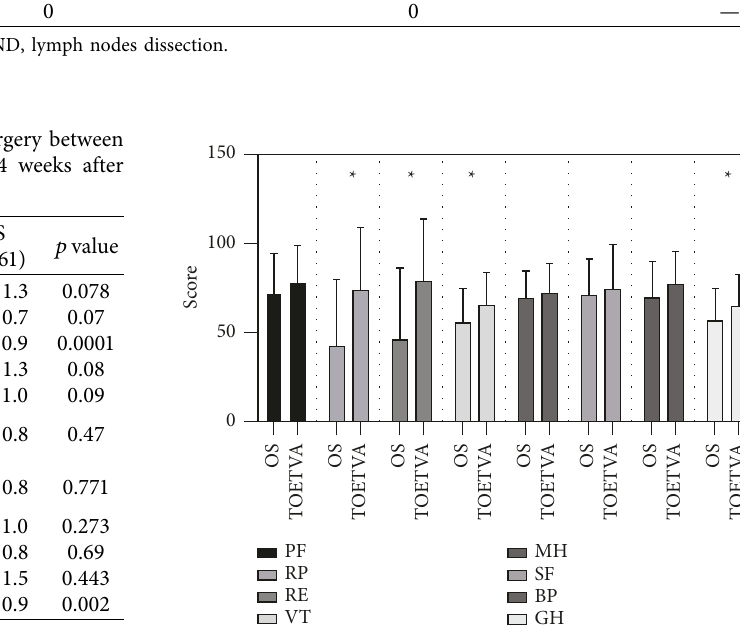
Figure 2: SF-36 score comparison between the TOETVA group and open surgery group at 4 weeks after surgery. BP � bodily pain, GH � general health, GP � general population, MH � mental health, RE � role-emotional, RP � role-physical, SF � social func- tioning, and VT � vitality. ∗ � statistical